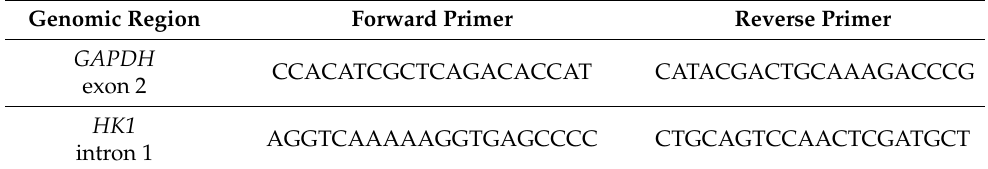
Table 4. Primers used for ChIP